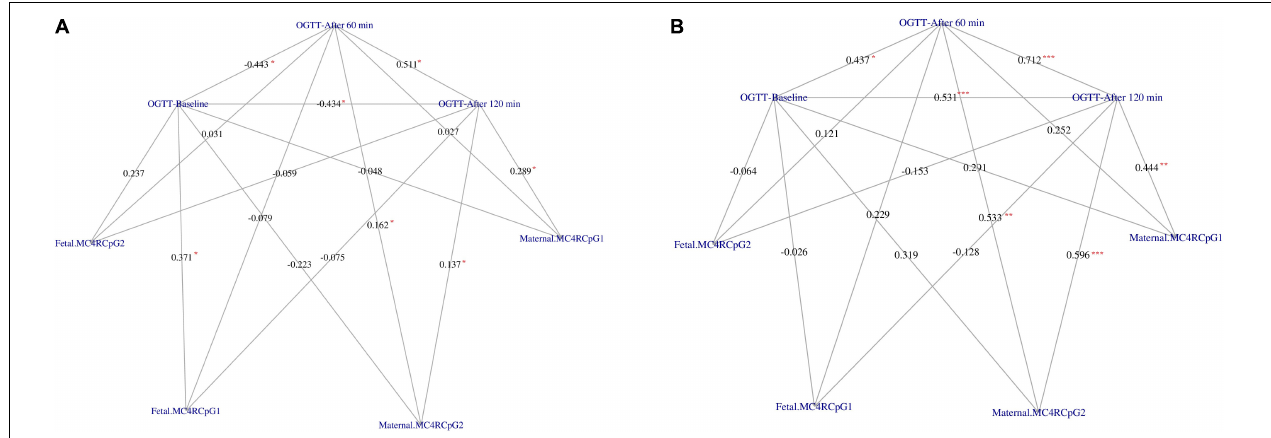
FIGURE 1 | Correlation network between OGTT glucose concentration at baseline, after 60 min and after 120 min with the CpG1 and CpG2 at the maternal and fetal side of placenta in GDM (A) and Controls (B) , respectively. The weight on the edges indicates the Spearman rank correlation coefficient (rho), the red color star indicates statistically significant correlation coefficient. Significance code: “*” = p < 0.050, “**” = p < 0.010, “***” = p < 0.001.